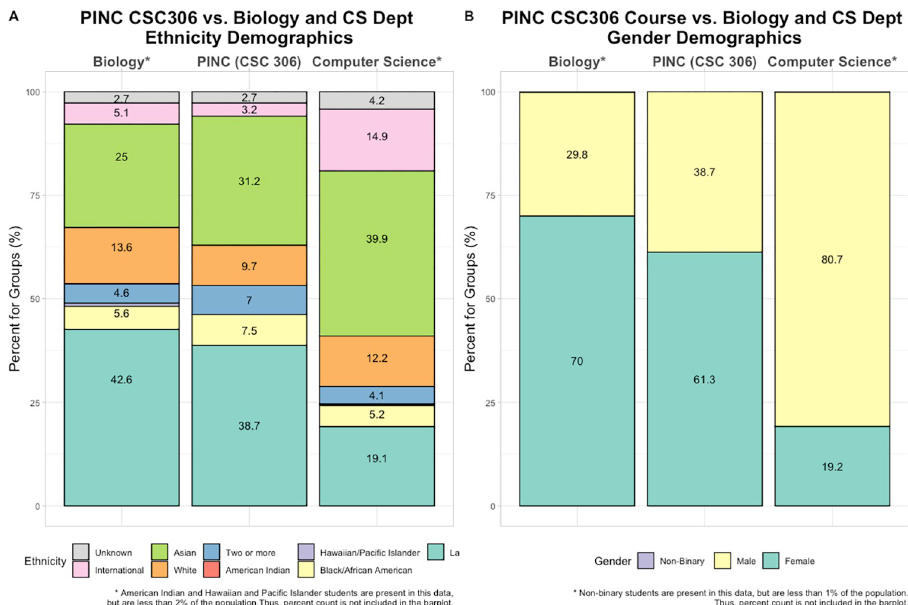
Fig 5. ( A ) Demographics of biology major (left), students in CSC 306 (the first class of the PINC minor, middle) and CS majors (right). Approximately 48% of biology majors are black or Latinx, compared to 24% in the CS major. The students in the PINC class CSC 306 reflect the demographics of the biology program; 46% of them are black or Latinx. Data from SFSU Institutional Research, based on 186 undergraduate students who took CSC 306 between 2016 and 2021. � American Indian and Hawaiian and Pacific Islander students are present in this data but are less than 2% of the population. Thus, they are present within the bar plot but the numerical label is not present in the figure. ( B ) Demographics of biology major (left), students in CSC 306 (the first class of the PINC minor, middle) and CS majors (right). Approximately 70% of biology majors identify as women, compared to 19.2% in the CS major. Approximately 61.3% of the students in the PINC class CSC 306 identify as women. Data from SFSU Institutional Research, based on 186 undergraduate students who took CSC 306 between 2016 and 2021. � Nonbinary students are present in this data, but are less than 1% of the population. Thus, they are present within the bar plot but the numerical label is not present in the figure. In addition, students who identify as nonbinary may not be listed as such in the university data